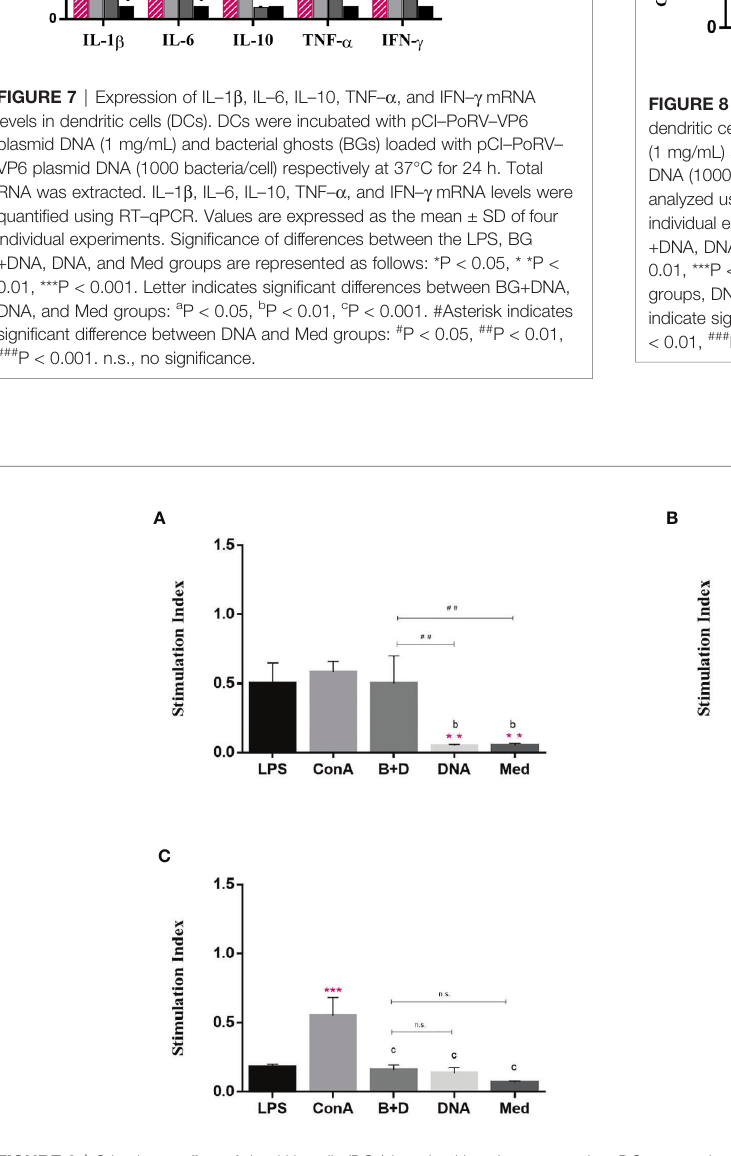
FIGURE 9 | Stimulatory effect of dendritic cells (DCs) by mixed lymphocyte reaction. DCs were stimulated with lipopolysaccharide (LPS, 100 ng/well), ConA (0.5 ng/well), plasmid DNA (1 mg/mL), or DNA – loaded bacterial ghosts (BGs, 1000 particles/cell) for 24 h. T lymphocytes were cultured in triplicate in 96 – well culture plates and then mixed with the cultured DCs at ratios of 1:1 (A) , 10:1 (B) and 100:1 (C) . T cell proliferation was measured using an MTT assay, the results are expressed as the stimulation index (SI). Values are expressed as the mean ± SD of fi ve individual experiments. Signi fi cance of differences between the LPS, ConA, BG+DNA, DNA, and Med groups is represented as follows: *P < 0.05, **P < 0.01, ***P < 0.001. Letter indicates signi fi cant differences between ConA, BG+DNA, DNA, and Med groups: a P < 0.05, b P < 0.01, c P < 0.001. #Asterisk indicates signi fi cant difference between, BG+DNA, DNA, and Med groups: # P < 0.05, ## P < 0.01, ### P < 0.001. n.s., no signi fi cance.